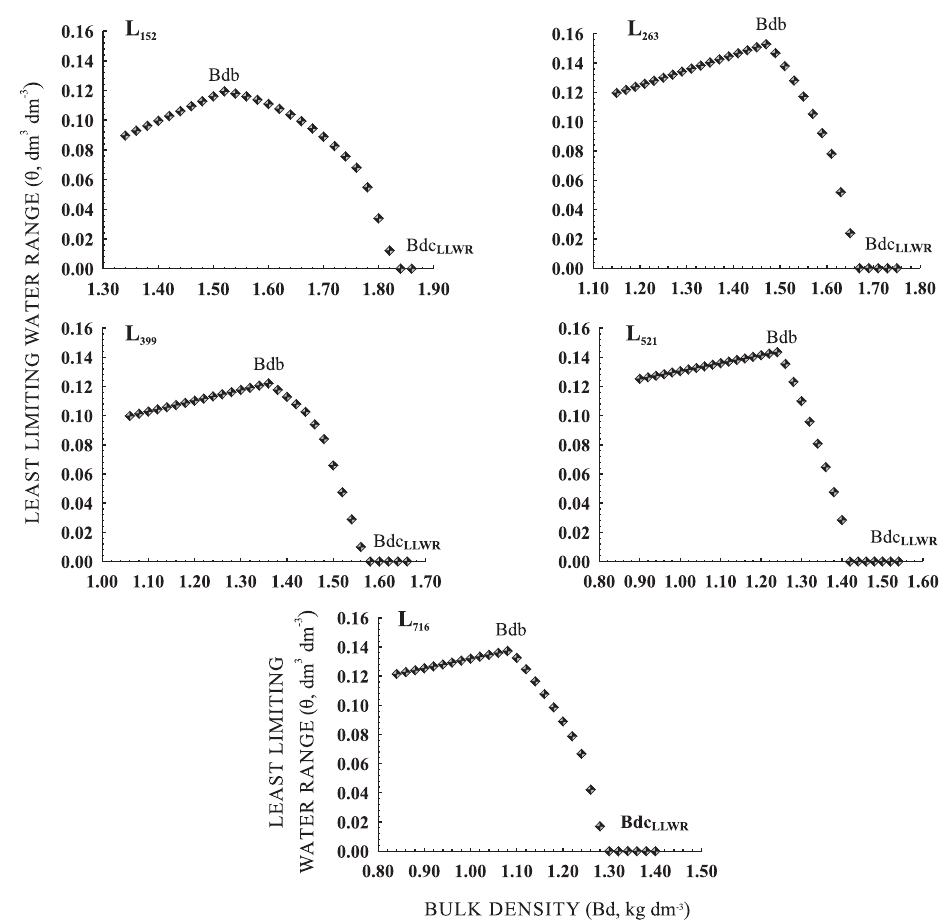
Figure 2. Variation of the least limiting water range (LLWR) with bulk density (Bd) in Latosols (L) in the county of Rio Verde, GO. Bdb: beneficial density to increase soil water retention; BdcLLWR: critical density for plant development, corresponding to LLWR. Subscripts in the abbreviation of Latosols indicate clay contents (g kg -1